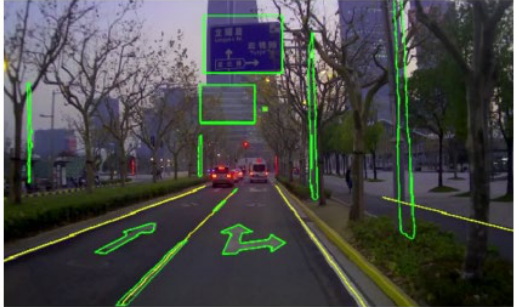
Figure 3. Example of semantic segmentation and detection results of local mapping on a vehicle.